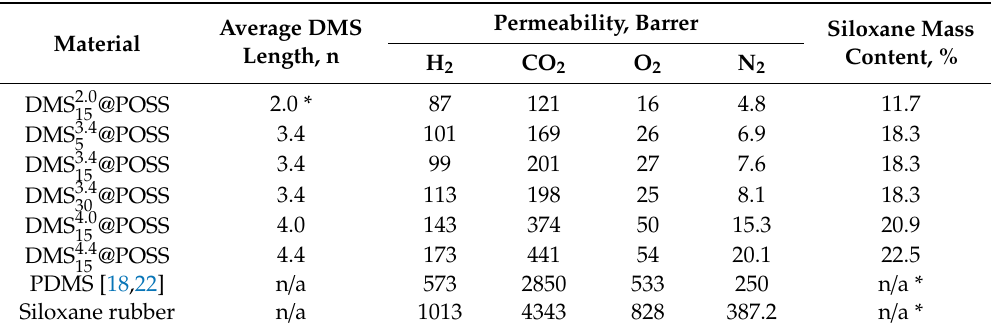
Figure 5. ( a ) Carbon dioxide / nitrogen selectivity as a function of carbon dioxide permeability for DMS x y @POSS samples (blue circle outline) polydimethylsiloxane and commercial silicone (red circle outline) compared to the wide variety of organic polymers published in literature [16] and Robeson upper bound [17]; ( b ) Same data represented in smaller scale to visualize the di ff erence between di ff erent materials (blue number next to the data point indicated the lengths of the DMS link, x in the material); ( c , d ) similar results for oxygen / nitrogen pair (red numbers indicate crosslinking density, y ); ( e , f ) similar results for hydrogen / nitrogen pair. Table 3. Summary of the gas permeabilities in DMS@POSS membranes compared to Sylgard PDMS and commercial siloxane sheet.